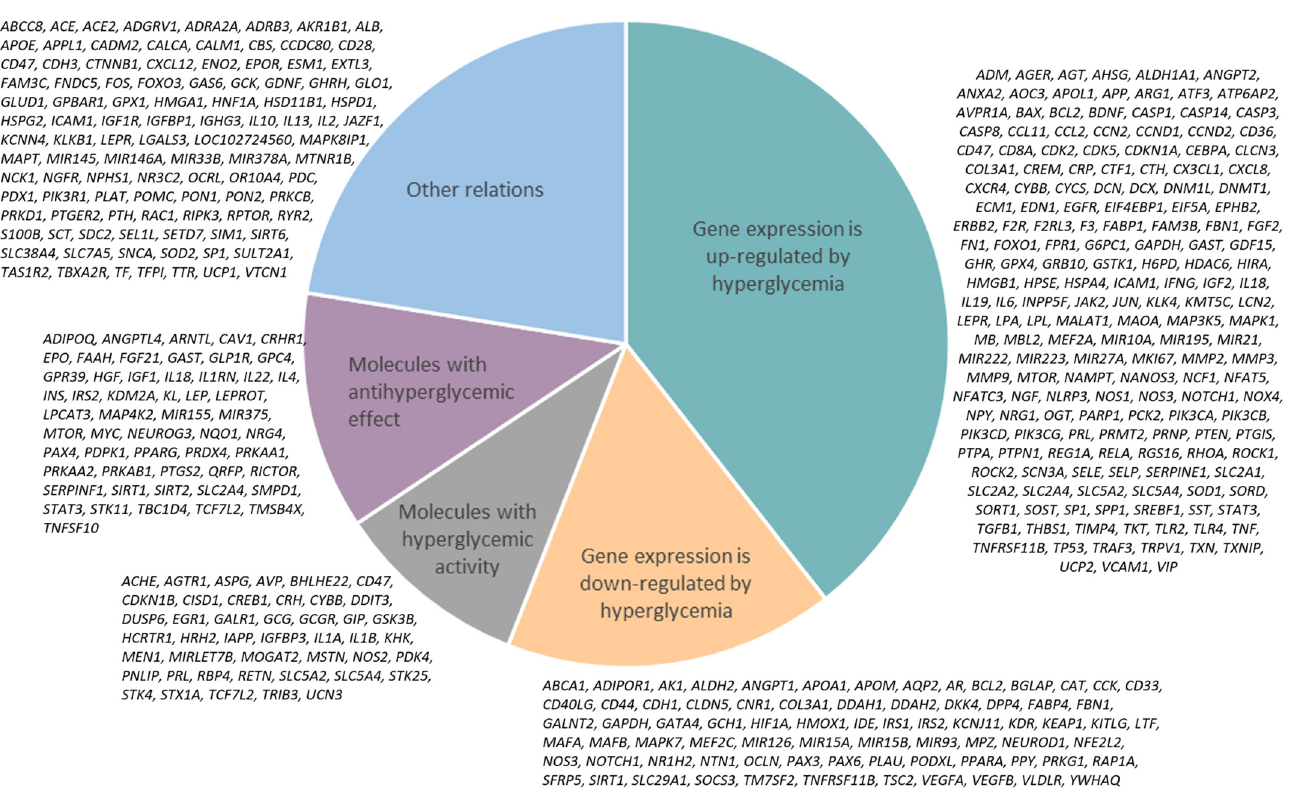
Figure 3. Types of associations between genes and HG in the hyperglycemia network. Insulin ( INS ), interleukin-6 ( IL6 ), tumor protein P53 ( TP53 ), mitogen-activated protein kinase 1 ( MAPK1 ), tumor necrosis factor ( TNF ), glyceraldehydes-3-phosphate dehydrogenase ( GAPDH ), epidermal growth factor receptor ( EGFR ), signal transducer and activator